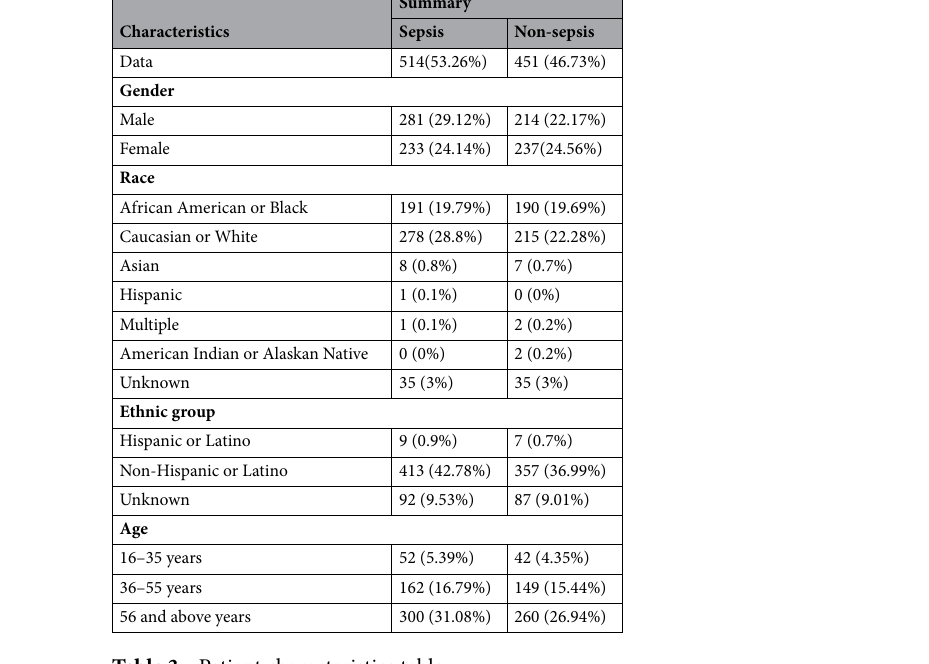
Table 3. Patient characteristics